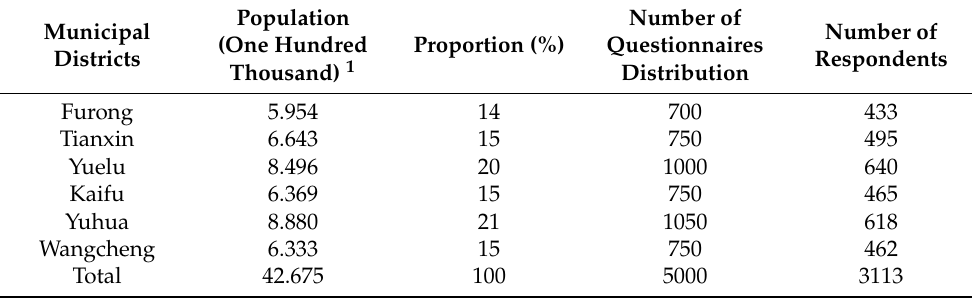
Table 1. Number of questionnaires distributed and recovered in municipal districts.